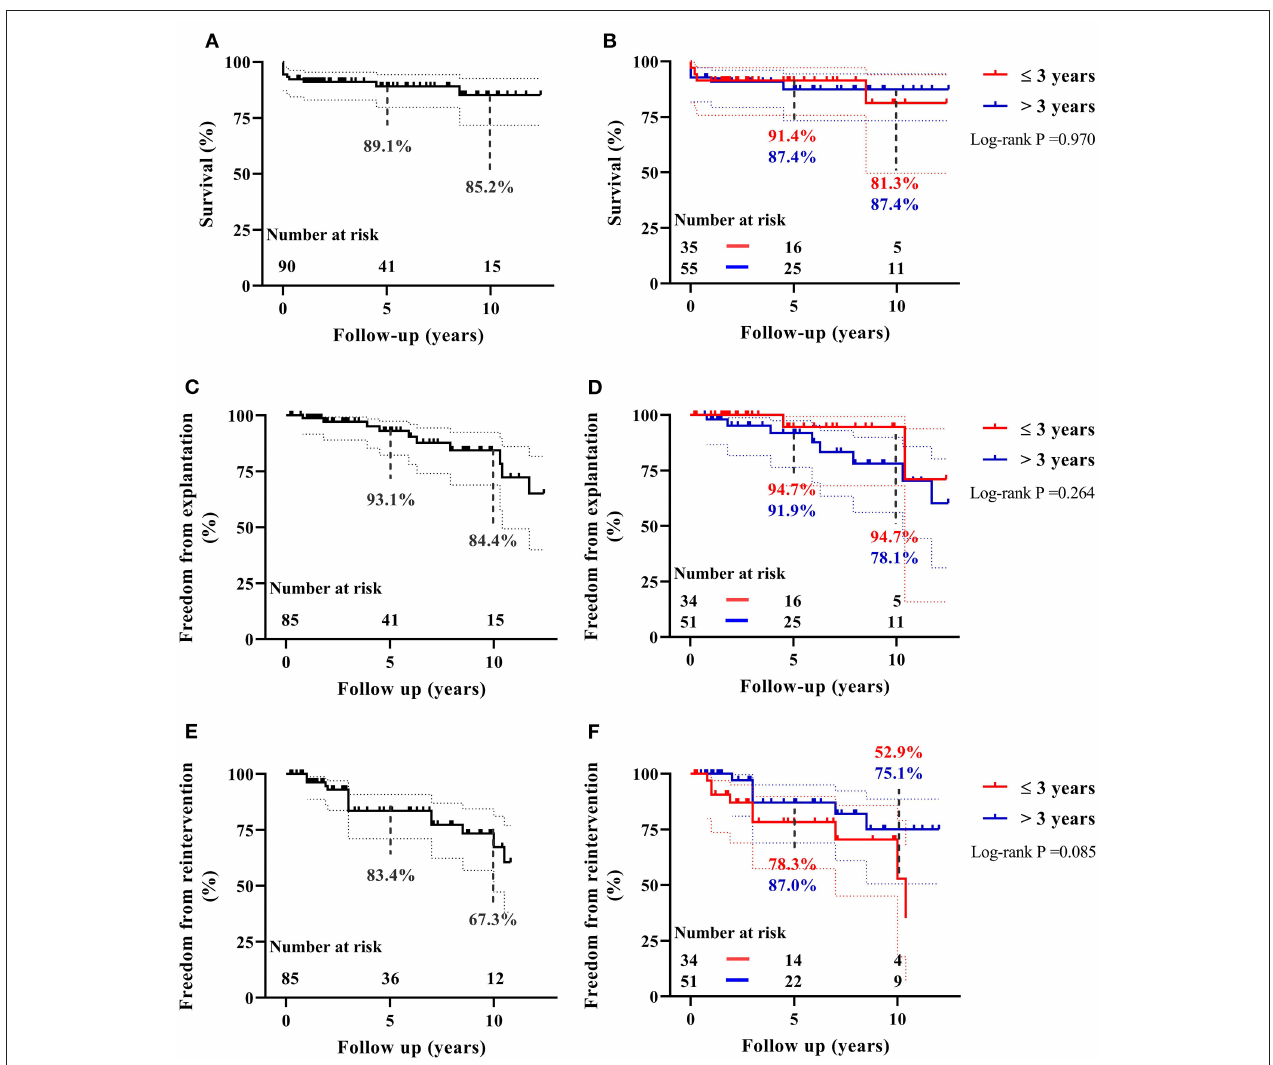
FIGURE 2 | The Kaplan–Meier estimates of overall survival, freedom from DP-BJVC explantation, and freedom from first catheter-based reintervention for the entire cohort are shown in (A) , (C) , and (E) , respectively. The comparisons of these estimated values between children ≤ 3 years and older patients are shown in (B) , (D) , and (F) , respectively. Dashed lines represent 95% CIs. In summary, the performance of DP-BJVC in young children ( ≤ 3 years) is similar with that in larger